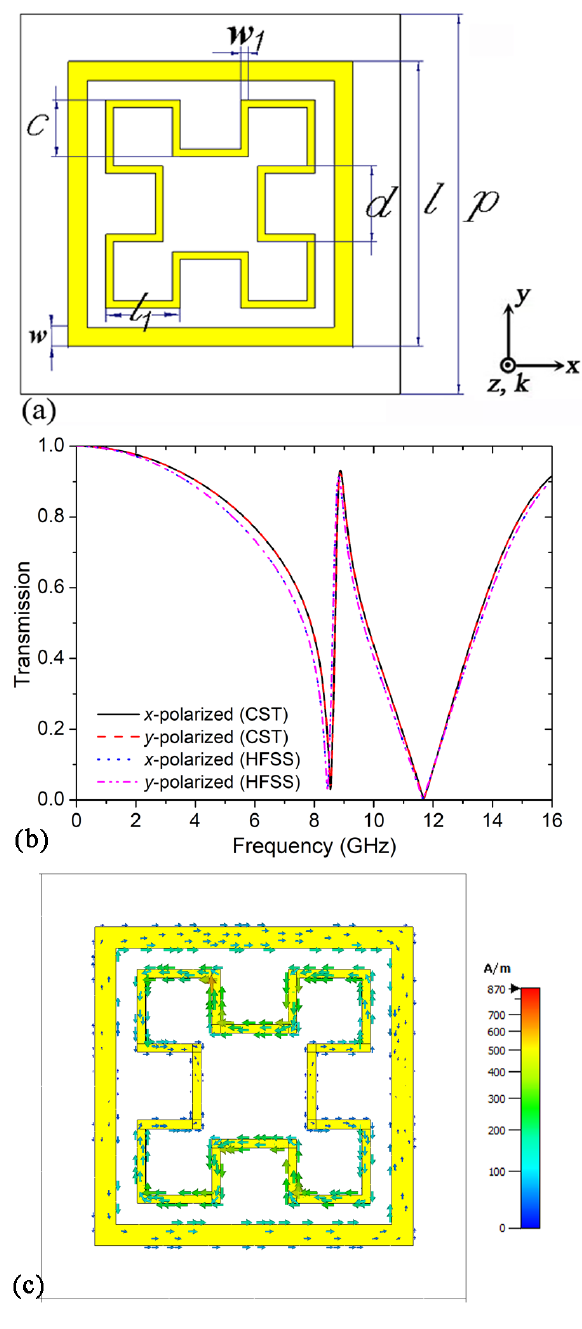
Figure 1: (a) Unit cell, (b) transmission spectra and (c) surface current distributions for the proposed first EIT-like